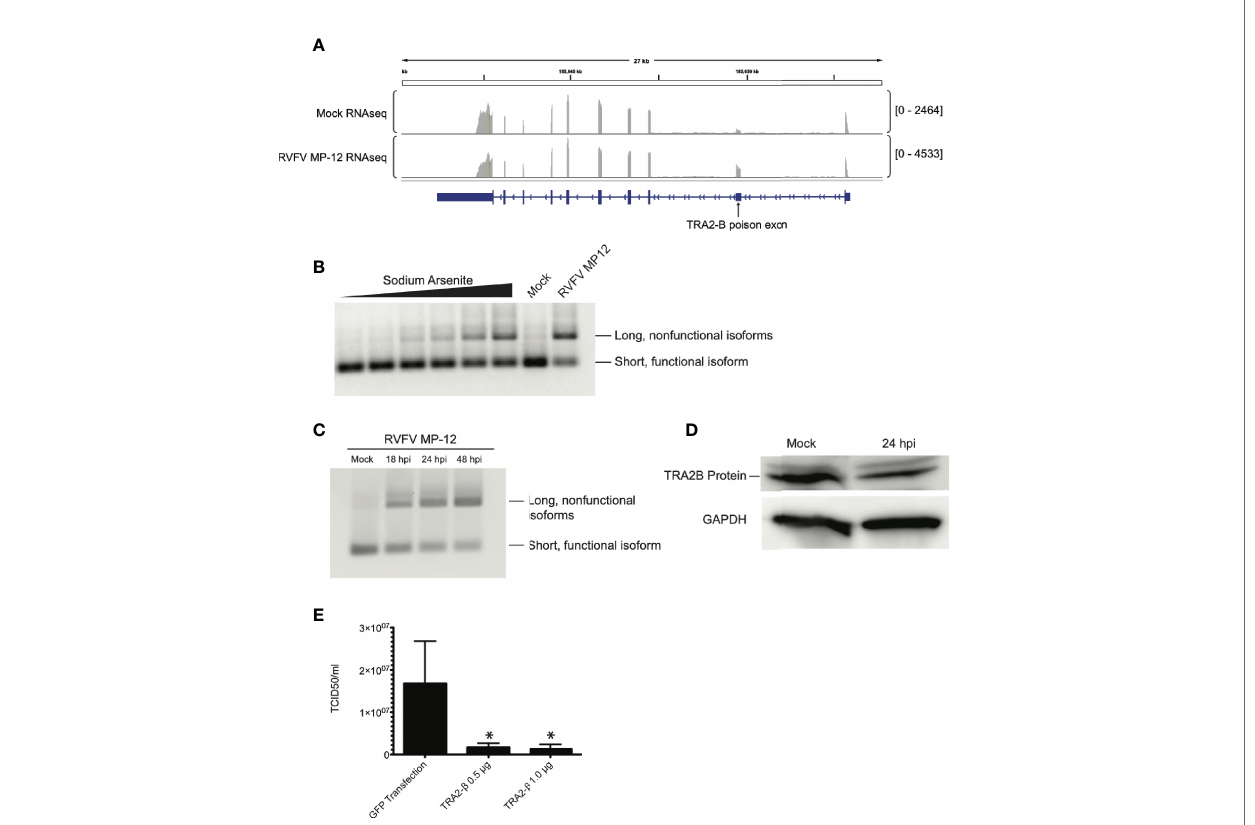
FIGURE 5 | TRA2- b mRNA is alternatively spliced in response to RVFV infection. (A) IGV tracks of mock- vs. RVFV MP-12-infected HEK293 cells at MOI = 1, highlighting TRA2- b . TRA2- b poison exon is labeled. (B) HEK293 cells were treated with sodium arsenite in increasing amounts (0, 1, 10, 25, 50, or 100 m M) or infected with RVFV MP-12 for 24h. RT-PCR with primers targeting TRA2- b mRNA was visualized by agarose gel. (C) HEK293 cells were infected with RVFV MP-12 at MOI = 1 for the times indicated, and RT-PCR against TRA2- b was performed. (D) HEK293 cells were infected with RVFV for 24h at MOI = 1, then cells were lysed and visualized via western blot. (E) TCID 50 results obtained by infecting naïve Vero cells using RVFV MP-12 particles obtained from HEK293 cells transfected with indicated plasmids and subsequently infected with RVFV MP-12 at MOI = 1. Asterisks indicate p < 0.05 compared to GFP transfection (one-way ANOVA followed by Tukey ’ s